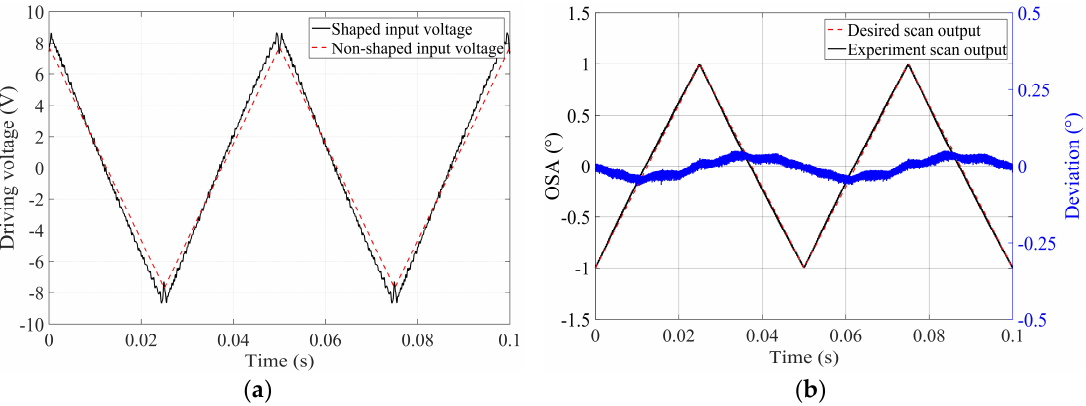
Figure 7. Performance of the input shaping method based on an experimental transfer function (ISETF): ( a ) the shaped input and non-shaped input for the optical scan range from −1° to 1° and ( b ) comparison between the ideal triangular output and the experimental scan output obtained using the shaped input based on an experimental transfer function (ETF).